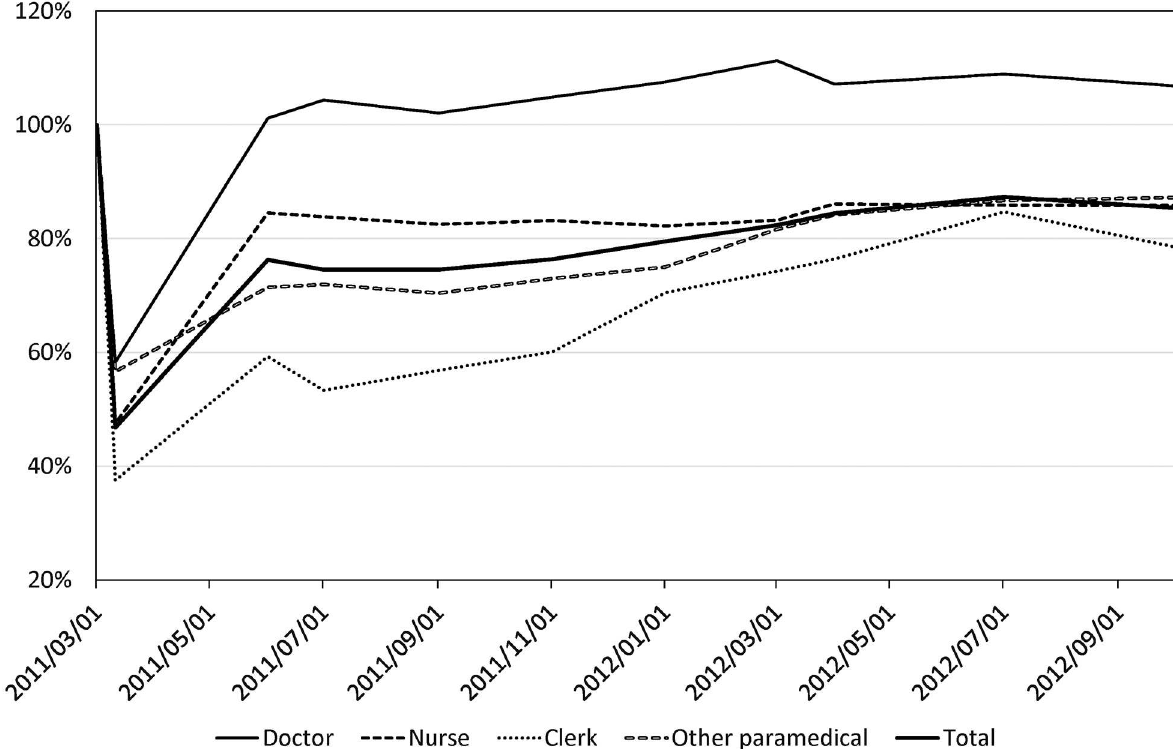
Fig 2. The % change in the number of hospital staff membersworking in the Soso district during the 18 months after the triple